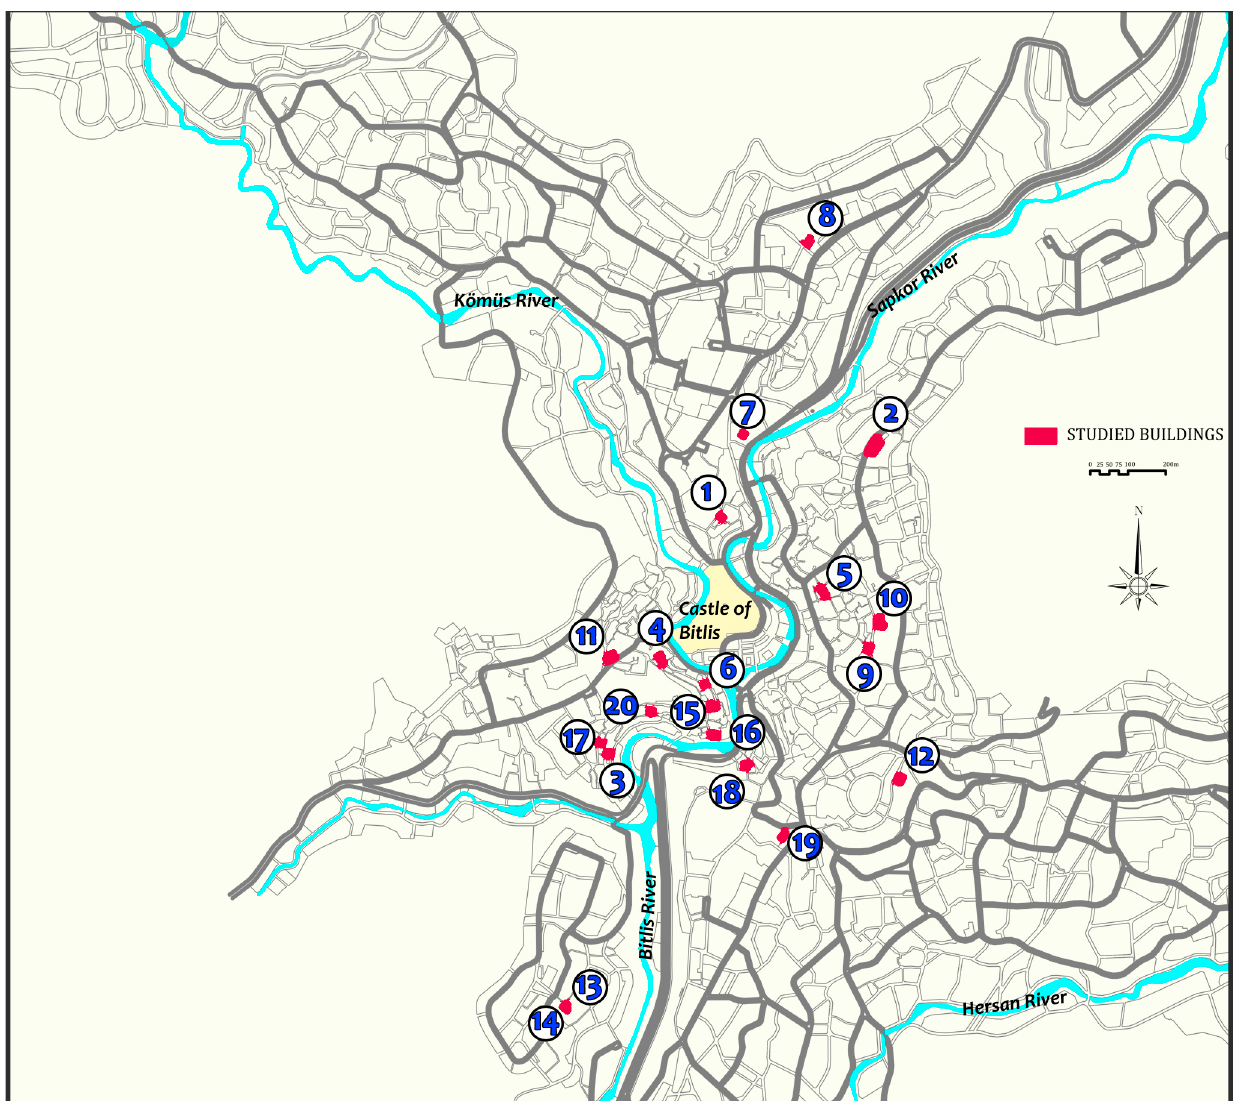
Figure 16. Locations of the twenty investigated structures in the city.